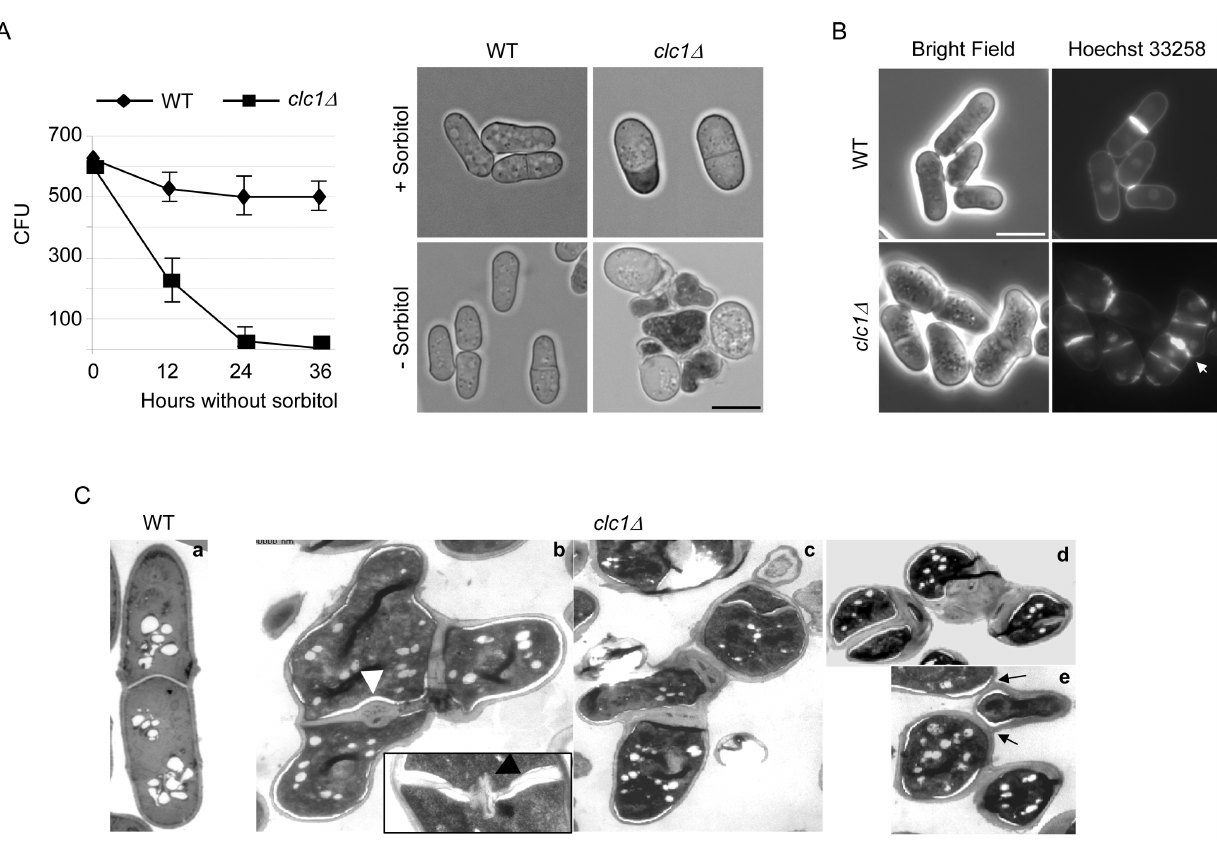
Figure 1. clc1 D cells are inviable in the absence of sorbitol and exhibit defects in morphogenesis. A. Left panel, cells from the indicated strains were transferred from YES plus sorbitol to YES medium and incubated at 28 u C. At the indicated times, 600 cells were plated onto sorbitol- supplemented YES medium and incubated at 28 u C for five days; the colony-forming units (CFU) were scored. The experiment was performed three times; the means of the values and the standard deviations are represented. Right panel, cells from the indicated strains grown in the presence or the absence of sorbitol for 12 hours were stained with Methylene blue and photographed. B. Cells from the wild-type and clc1 D strains were grown in YES with sorbitol and stained with Hoechst 33258 to observe nuclei and cell wall; the arrow denotes a septum thickened in its central region. In A and B the bar represents 10 m m. C. Electron microscopy of wild-type and clc1 D cells grown in the presence of sorbitol. One cell from the control strain (panel a ) and different cells from the null clc1 D mutant (panels b to e ) are shown. Arrowheads in panel b denote septa that are thickened at their central region; arrows in panel e point to cell wall remnants that join cells after division.